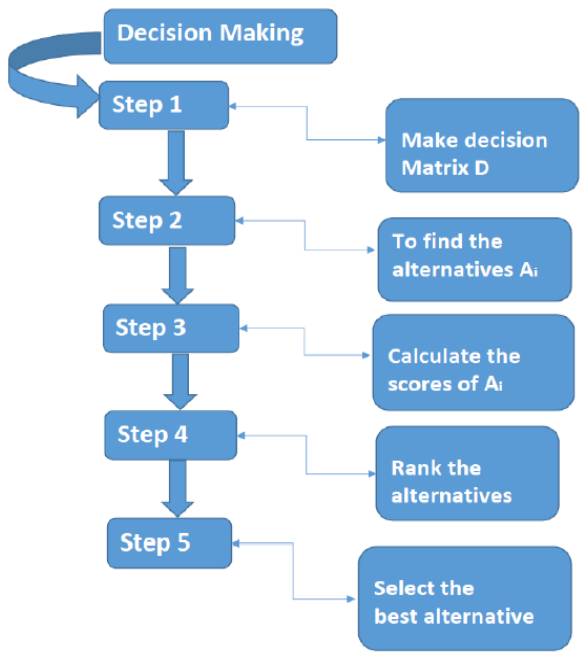
Figure 3. Flow chart of algorithm.